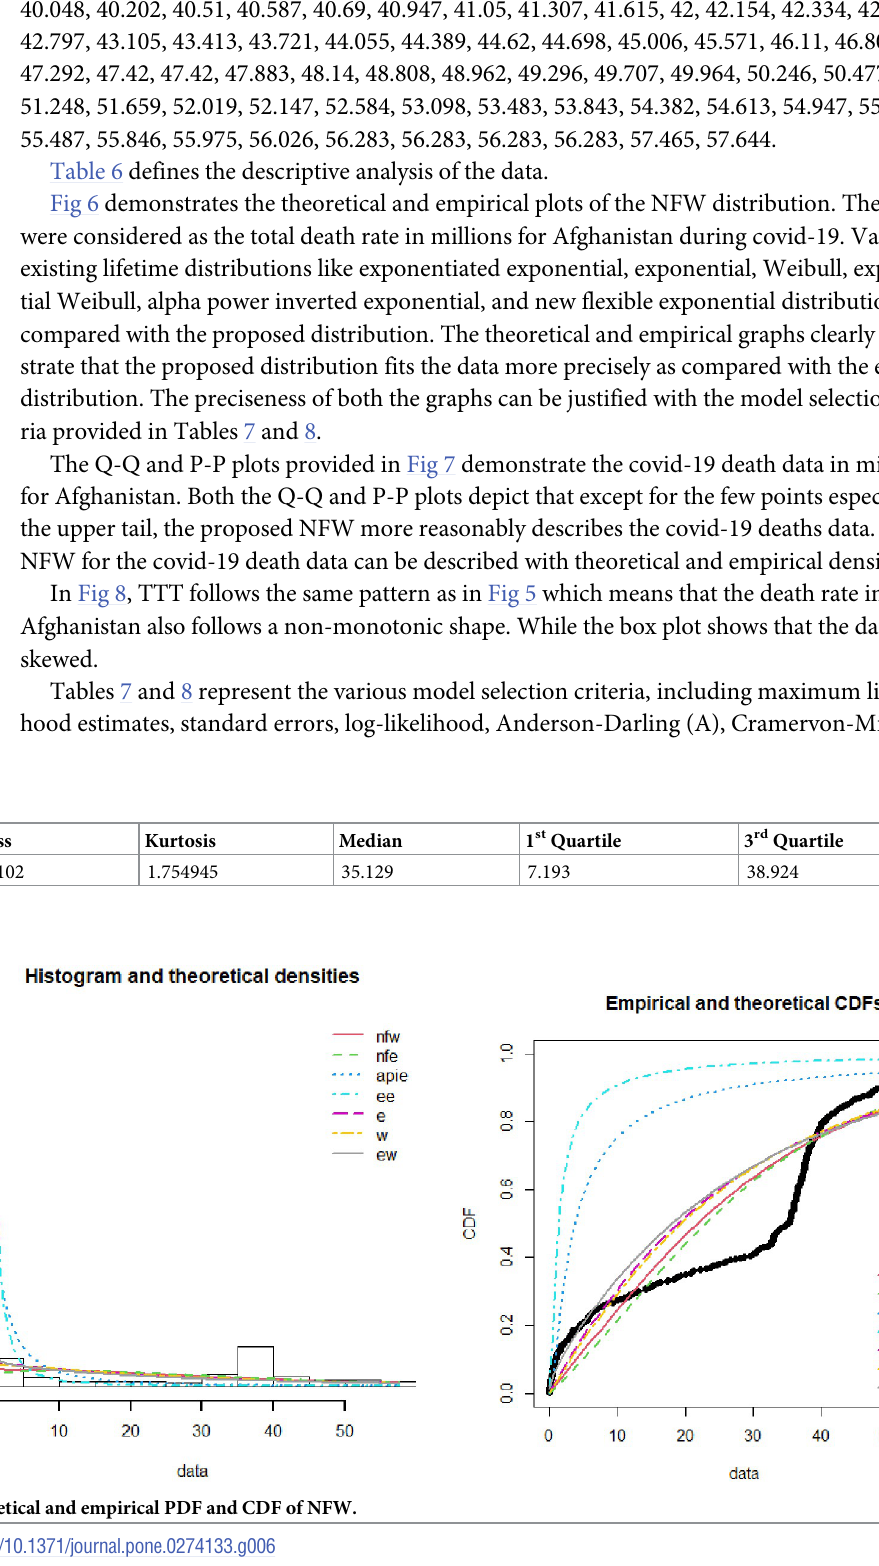
Table 6 defines the descriptive analysis of the data.